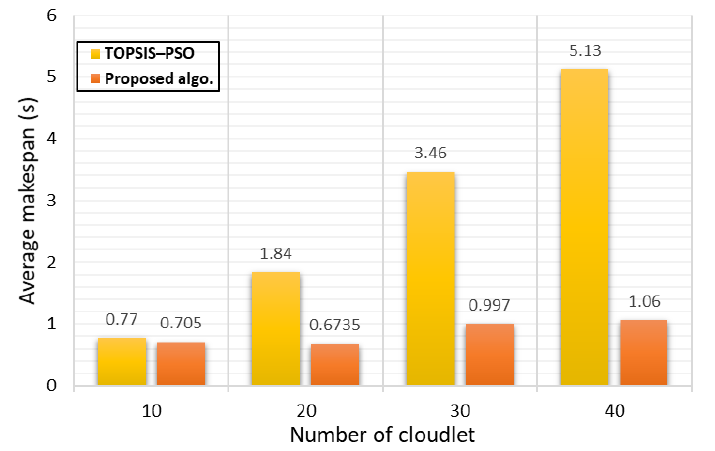
Figure 5. Average